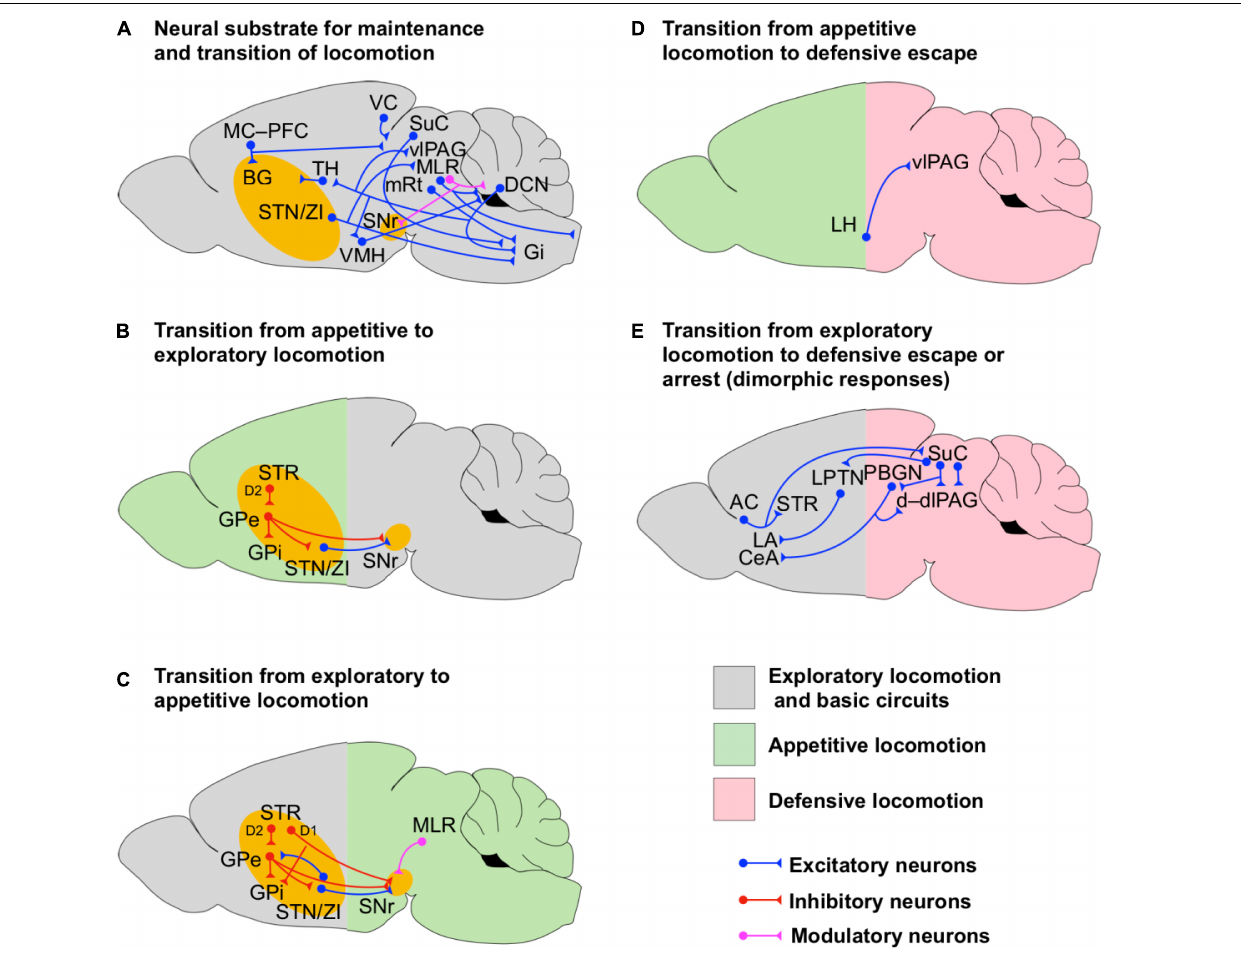
FIGURE 2 | Circuits for transition and maintenance of locomotion. (A) Scheme of the neuronal circuits underlying the maintenance and transition of locomotion. The intricate network among the cerebellum, BG, hypothalamus, PAG, MLR and their projections to Gi are shown. (B,C) Scheme of the BG neuronal circuits supporting the bidirectional transition from appetite to exploratory locomotion (B) and exploratory to appetite locomotion (C) . Notice that the transition from exploratory to appetitive locomotion is supported by feedback modulatory projections from MLR. The BG circuits are highlighted in yellow to indicate that they are involved in the initiation of a particular state even if they are not fully shown for simplicity. (D) Scheme of the neuronal circuits underlying the transition from appetitive to defensive locomotion. (E) Scheme of the neuronal circuits underlying the transition from exploratory locomotion to dimorphic defensive escape or arrest. Notice that the dimorphic defensive behaviors are driven by visual or auditory sensory inputs routed via the superior colliculus (SuC) and auditory cortex (AC)